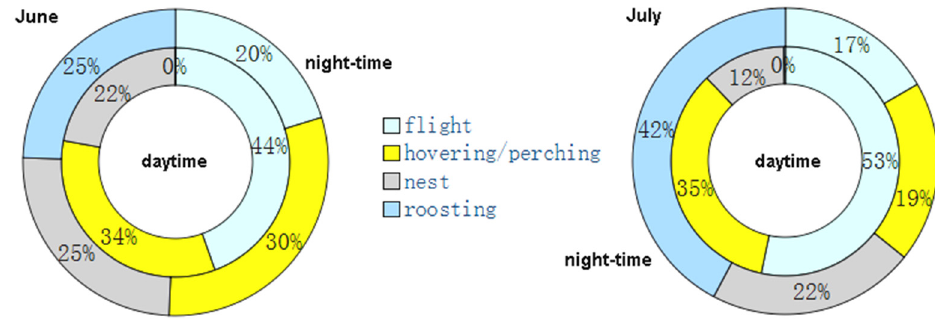
Figure 6. Nested ethograms of the tracked red-footed falcons in the daytime (inner doughnut) and night-time (outer doughnut) for (left) June and (right) July.